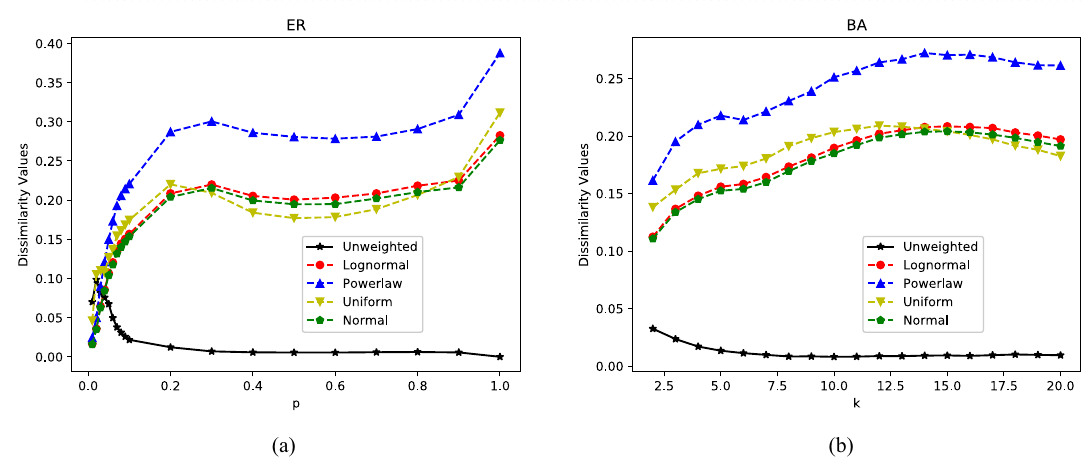
Figure 3. Comparison between incomplete graphs with different edge densities. The black curves depict the differences between two unweighted networks with the same density change with the probability p of connecting pairs of nodes or average degree k . Other colored curves show the differences between weighted network and its binary counterpart at various densities. The edge weights are drawn from lognormal distribution ( E ( x ) = 1, σ = 0.1 ) , power-law distribution ( b = 1 ) , uniform distribution U [0, 2] and normal distribution (µ = 1, σ = 0.1 ) . ( a ) The difference between Erdos–Renyi ( ER ) networks; ( b ) The difference between Barabasi– Albert ( BA )